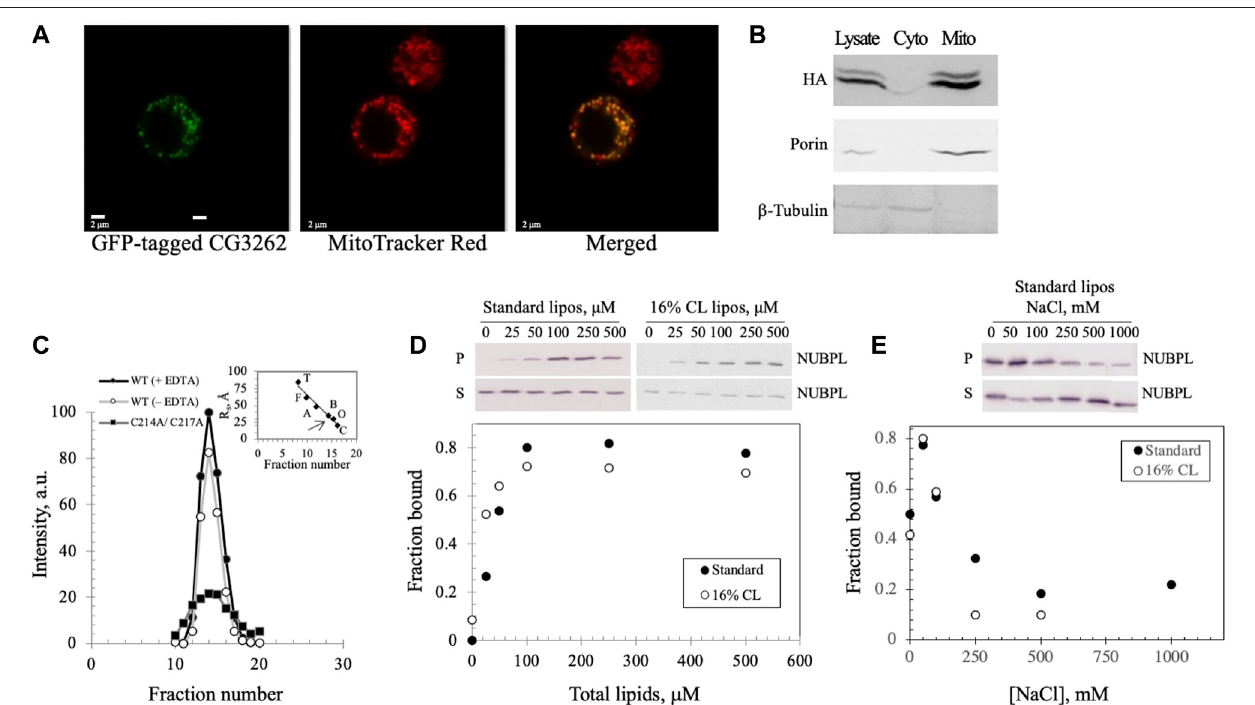
FIGURE5| Dm NUBPLisaperipheralmembraneproteinthatlocalizestomitochondriaandformsahomodimerregardlessofthepresenceofanapparentISC. (A) Representative confocal microscopic images of a GFP-tagged Dm NUBPL and (B) immunoblot of a HA-tagged Dm NUBPL show mitochondrial localization of Dm NUBPL. Porin and β -tubulin were used as loading controls for mitochondria and cytosol, respectively. (C) Gel fi ltration of an N-terminally His-tagged recombinant Dm NUBPL shows that Dm NUBPL in the presence (closed circles) or absence of EDTA (open circles), and an ISC coordination-de fi cient variant (C214A/C217A) (closed squares) produced a single peak with the same Stokes radius of 37 Å. Protein standards used for column calibration were: carbonic anhydrase (C, 20 Å, 29 kDa), ovalbumin (O, 30 Å, 45 kDa), bovine serum albumin (B, 35 Å, 66 kDa), aldolase (A, 48 Å, 158 kDa), ferritin (F, 61 Å, 440 kDa), and thyroglobulin (T, 85 Å, 669 kDa). The position of the eluted recombinant Dm NUBPL peak is indicated by an arrow on the standard protein curve in the inset. (D) Liposome cosedimentation assay shows that puri fi ed Dm NUBPL (0.4 μ M) binds to asolectin liposomes excluding (closed circles) or including 16% w/w CL (open circles) similarly. P is the pellet fractionandSisthesupernatantfraction afterultracentrifugation. (E) NaCldisruptstheelectrostaticinteractionsthathold Dm NUBPLtoliposomesinadose-dependent